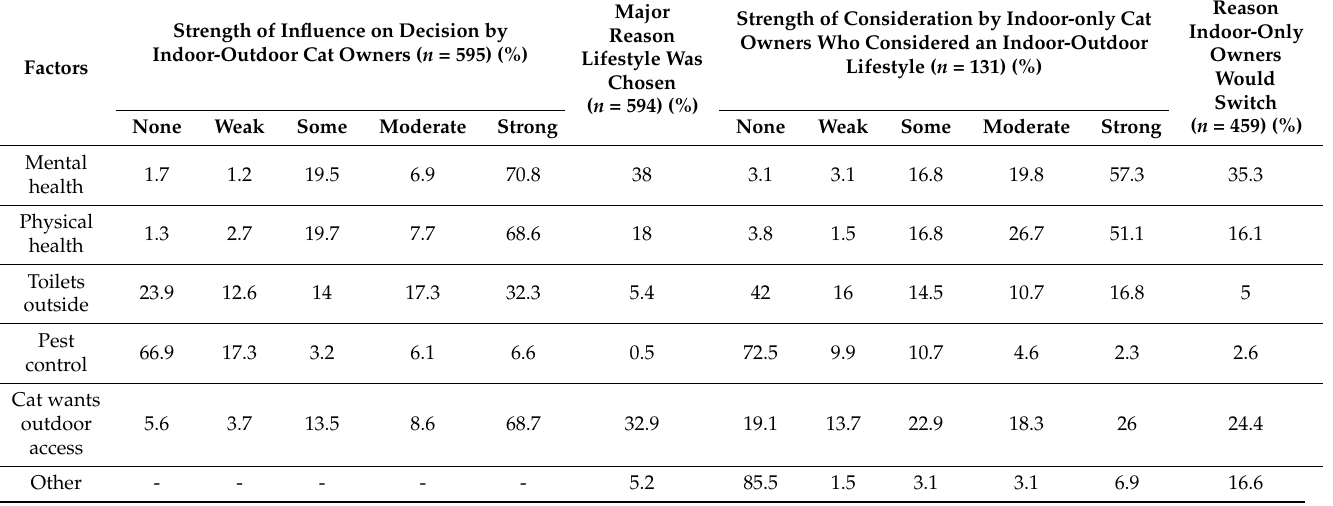
Table 7. Percentages of indoor-outdoor cat owners ( n = 595) reporting different influence strength of factors considered during their decision to choose their cats’ lifestyle, with their major influencing reason. Percentages of consideration given by indoor-only owners who considered and an indoor-outdoor lifestyle for their cat ( n = 131) and the percentage of indoor-only cat owners ( n = 459) who gave different reasons when asked for the major factor that would cause them to change their cat to an indoor-outdoor lifestyle.